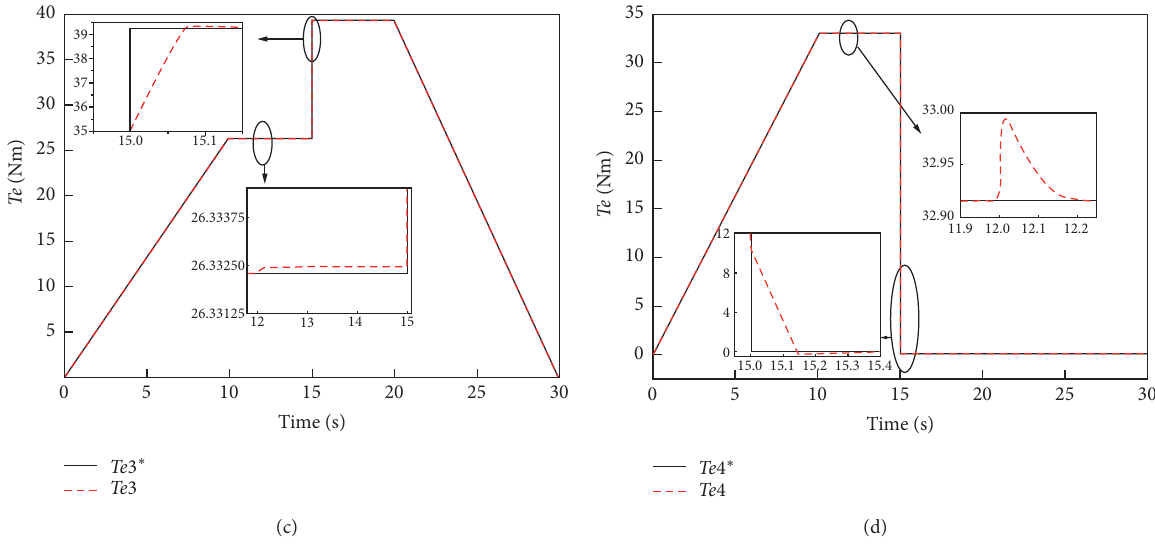
Figure 4: Output torque change curve of the four motors when the fourth motor loses 100% traction. (a) Output torque change curve of motor 1. (b) Output torque change curve of motor 2. (c) Output torque change curve of motor 3. (d) Output torque change curve of motor 4.